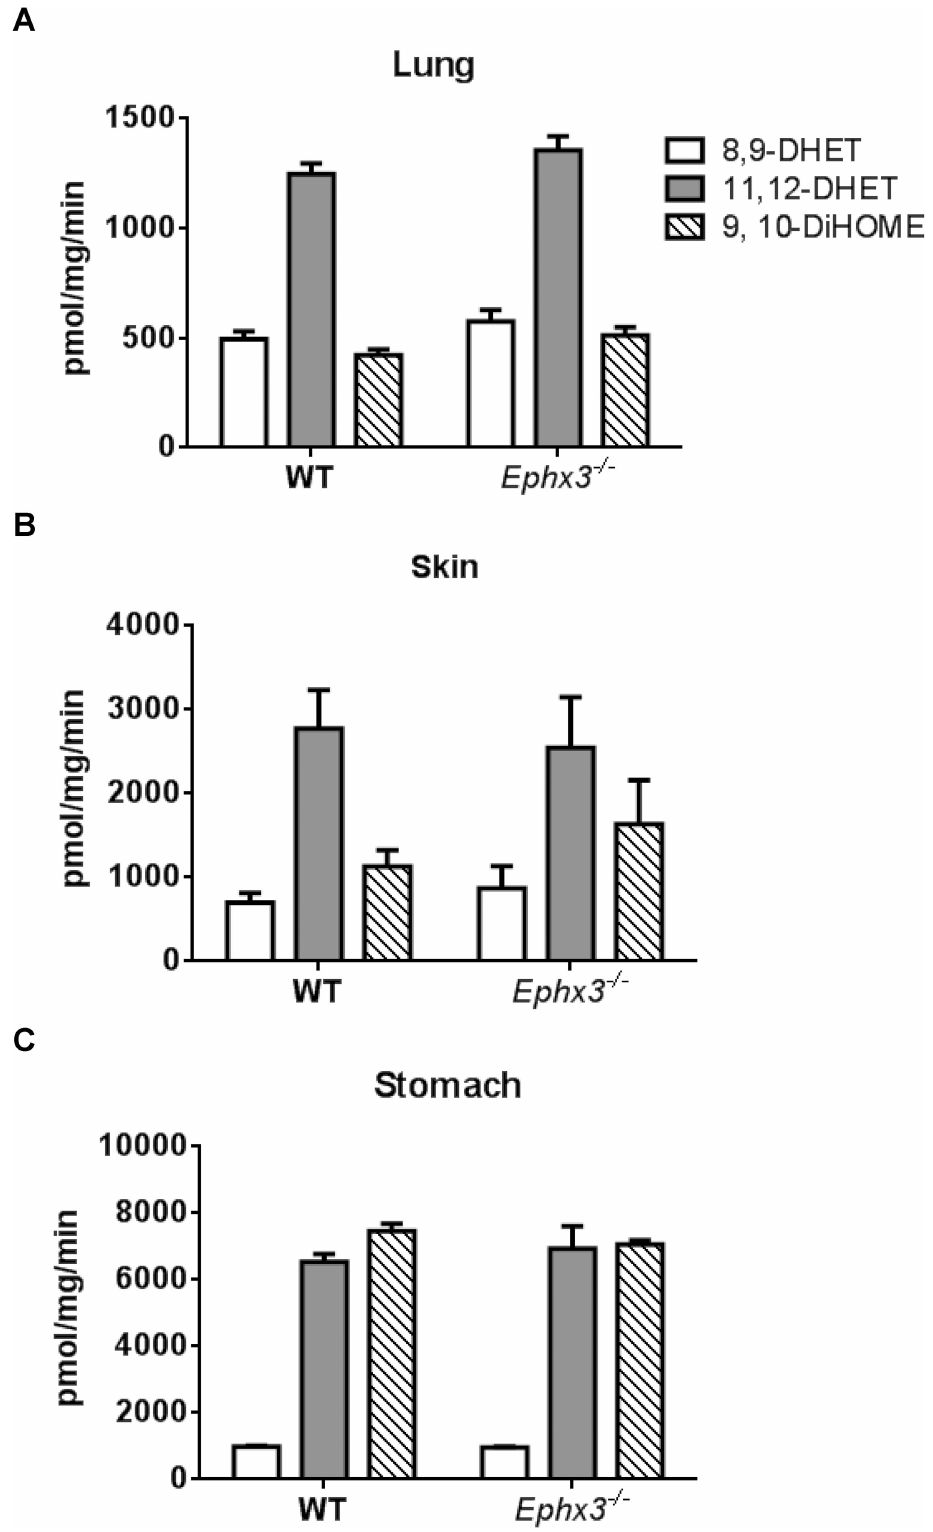
Fig 6. Incubation with synthetic EETs/EpOMEs showes no changes in diol formation rate in Ephx3 -/- mice. LC-MS/MS analysisof diol formation after a 5 minute incubationwith synthetic EETs or EpOMEs in (A) lung, (B) skin, and (C) stomach lysates from Ephx3 -/- and WT mice. (n = 5–10, p = NS).